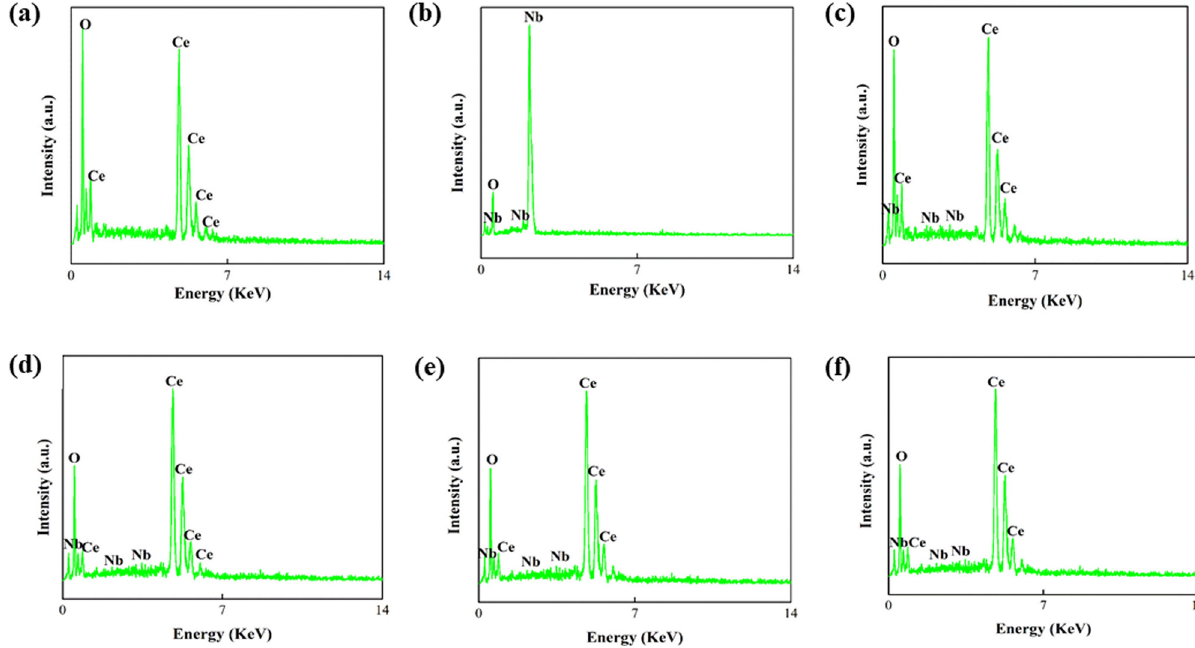
Figure 5: EDS plots obtained for the materials ( a ) CeO 2 ; ( b ) Nb 2 O 5 ; ( c ) 1.5 wt% doped, ( d ) 2.5 wt% doped, ( e ) 3 wt% doped, and ( f ) 50 wt% doped Nb – CeO 2